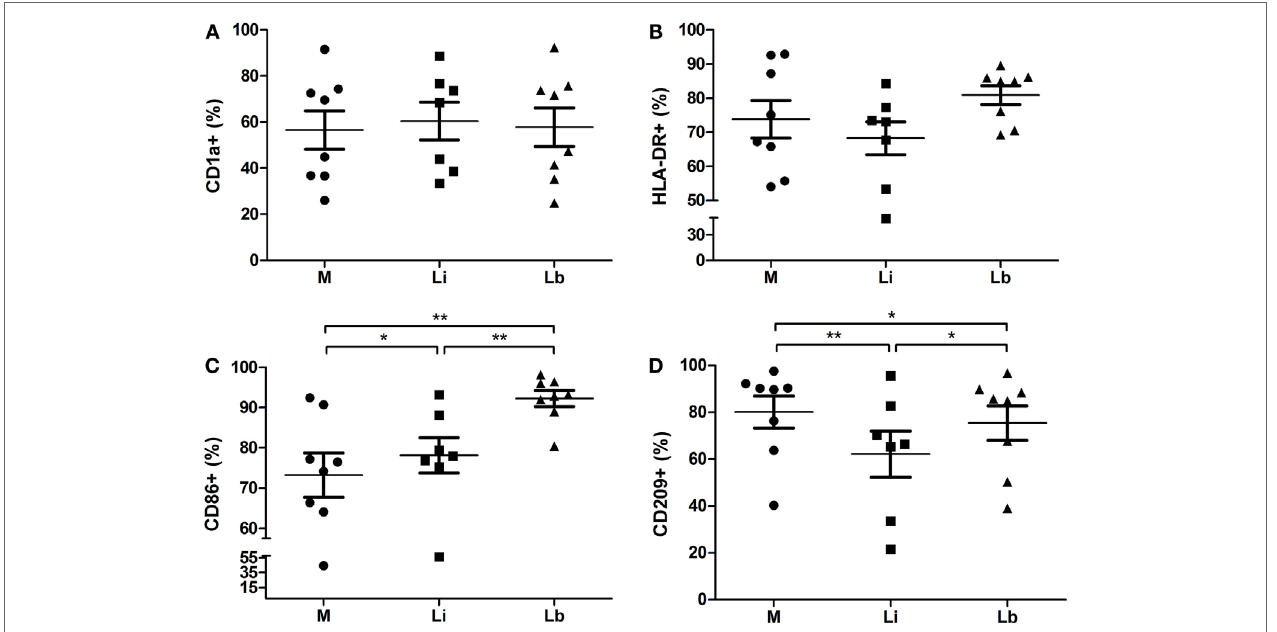
FigUre 3 | L. braziliensis - or L. infantum- exposed dendritic cells upregulate cD86 and downregulate cD209 expression – flow cytometry analysis of surface molecule expression in immature Dcs differentiated from human monocytes with cytokine-conditioned media (M) or conditioned media in the presence of viable L. infantum (li) or L. braziliensis (lb) . CD1a (a) , HLA-DR (B) , CD86 (c) , and CD209 (D) . Median ± SD. Each point represents one donor. * p < 0.05, ** p < 0.01.